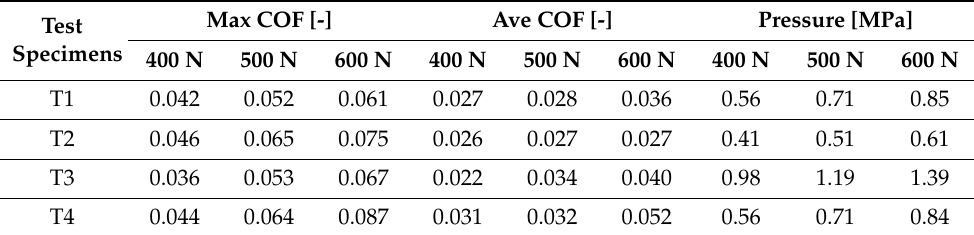
Figure 10. Friction coefficient curve of friction disks. Table 6. Friction coefficient and pressure value of friction disk (constant speed